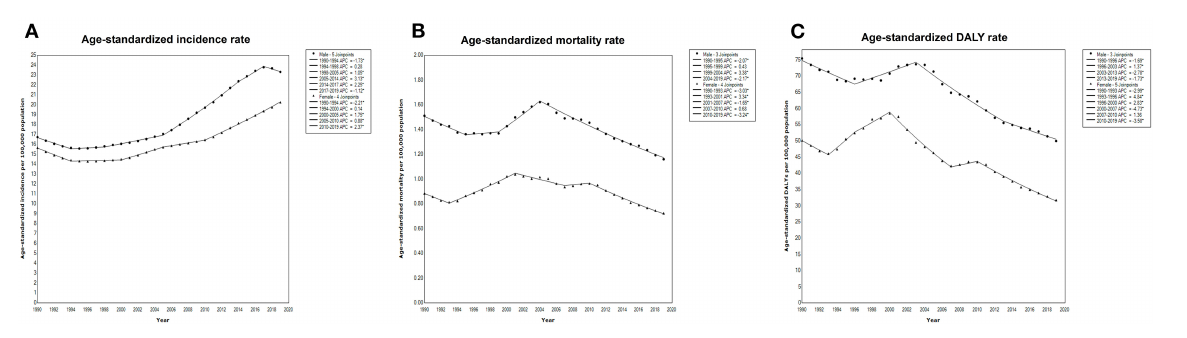
FIGURE1 Joinpoint regression analysis of the age-standardized (A) incidence, (B) mortality, and (C) DALYs due to CO poisoning according to sex in China from 1990 to 2019.